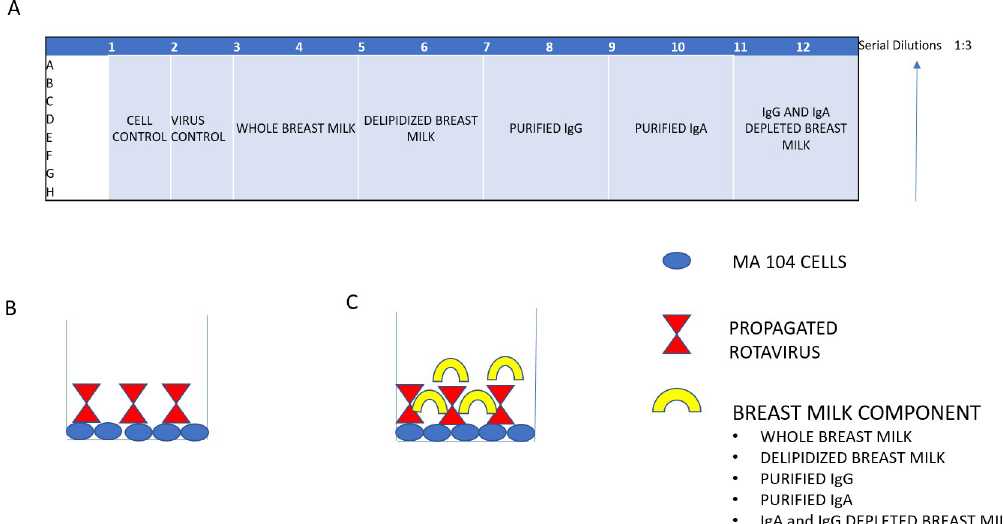
Fig 2. Inhibition plate setup in a 96 well microtitre plate for each breastmilk sample (A). Each plate consisted of a Cell control in which only MA104 cells were grown (Column 1), Virus Control which had MA104 cells and virus only (Column 2, B), the remaining columns constituted MA104 cells, virus and breastmilk sample (columns 5–12, C) (delipidised breastmilk–columns 5 and 6, Purified IgG–columns 7 and 8, purified IgA- columns 9 and 10 and IgA and IgG depleted breastmilk -columns 11 and 12). All breastmilk samples were serially diluted to the ratio of